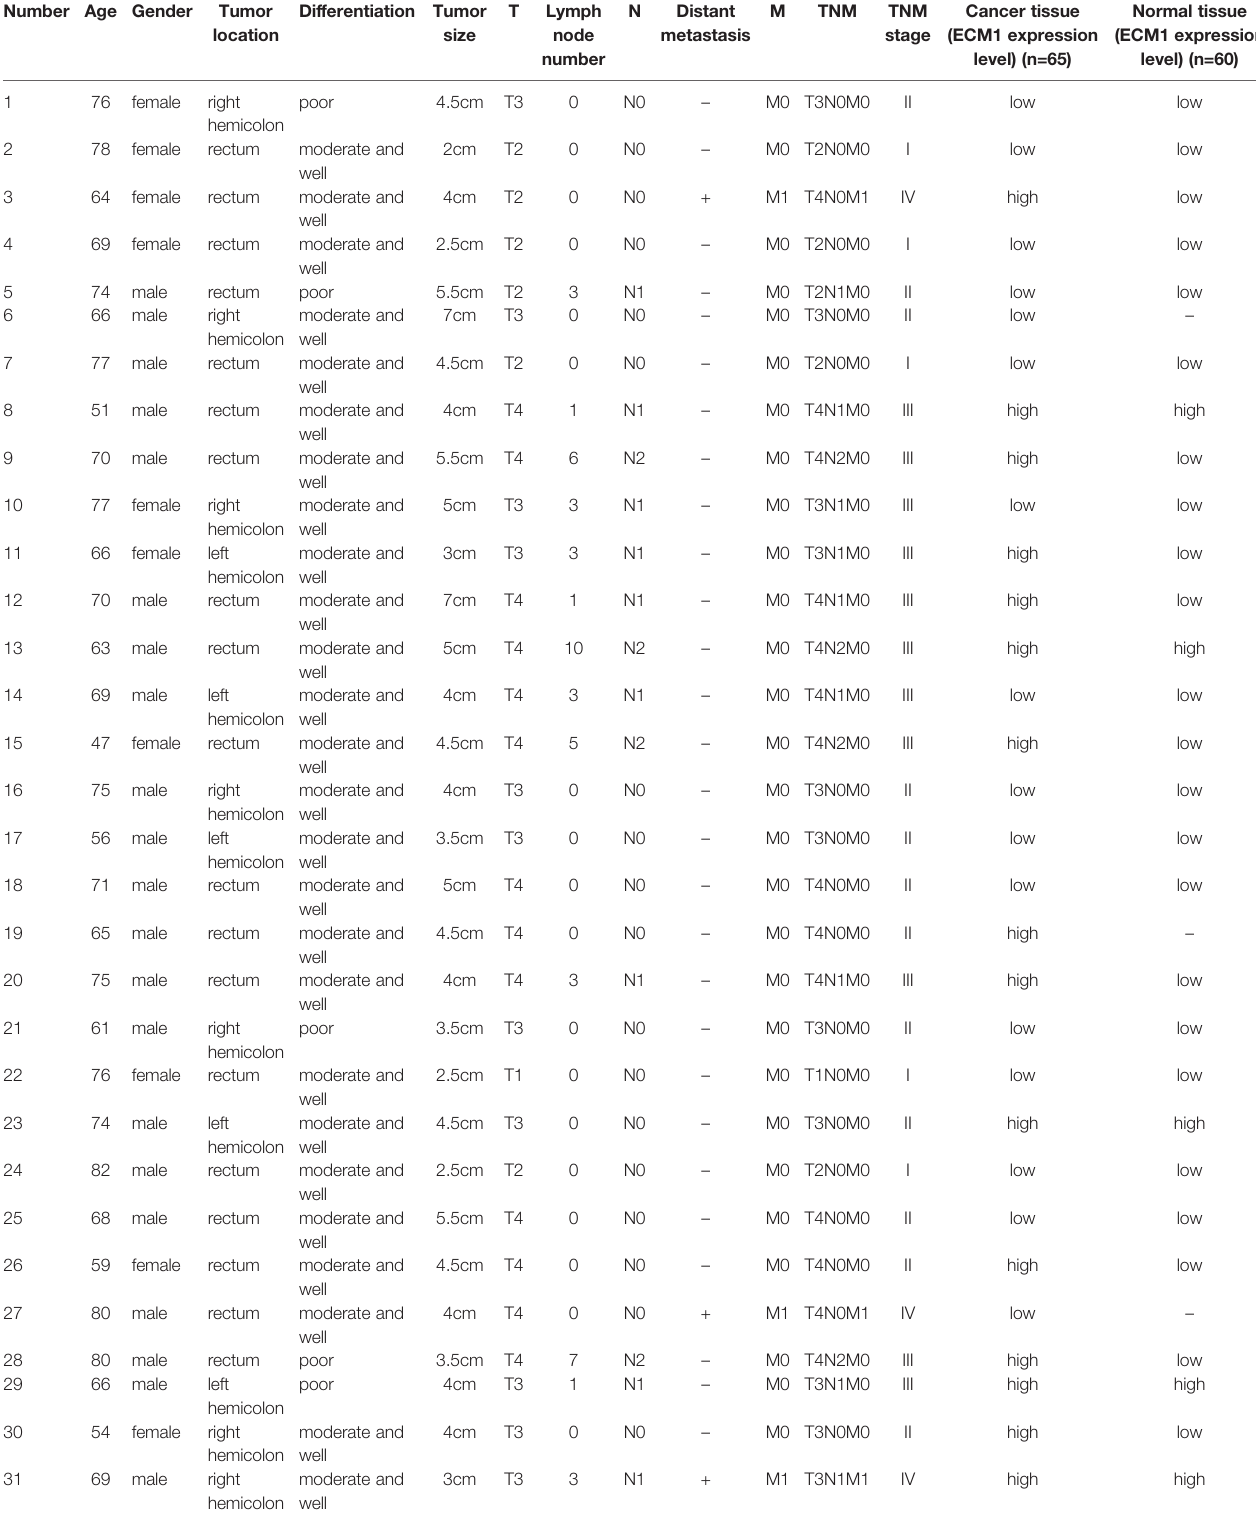
TABLE 3 | Patients ’ clinical information and ECM1 expression